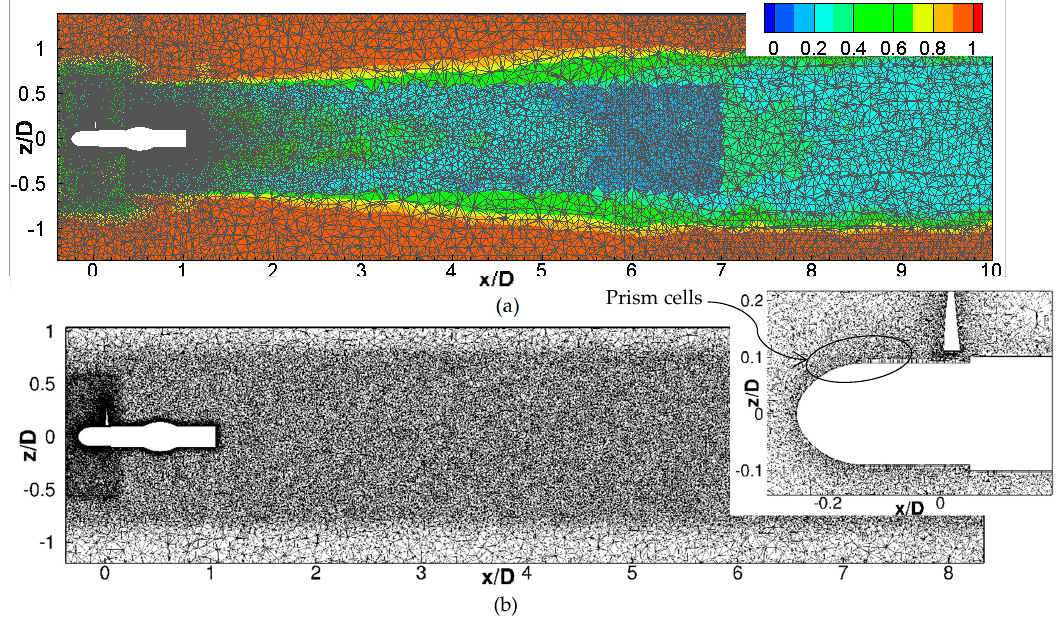
Figure 3. Cross-sectional view of the grid at y / D = 0 plane used in the simulations. ( a ) The fine 8.8 M grid used in Ansys / Fluent simulations. The contour plot shows the ratio of grid scale ( ∆ ) and turbulence length scales ( (cid:96) ). F HRL = ∆ / (cid:96) = 1 is unsteady Reynolds averaged Navier-Stokes (URANS) region and F HRL = 0 is Large Eddy Simulation (LES) region. ( b ) The 11 M grid used in OpenFOAM simulations. The inset plot shows the prismatic cells in the boundary